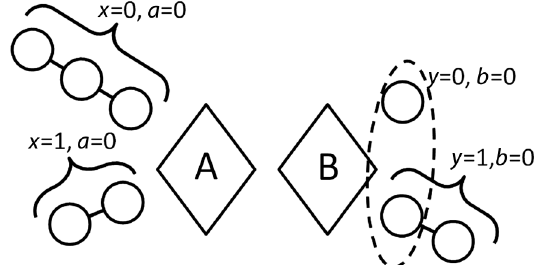
FIG. 1. Pictorial representation of the state constraints: The diamonds (heads) denote Alice ’ s and Bob ’ s state spaces; the circles represent rank-one projectors. N circles joined by a line (legs) must be understood as living in the symmetric space of N particles. In the figure, Alice ’ s projectors j u 1 ih u 1 j , j u 2 ih u 2 j are represented by legs of lengths 3, 2, respectively. Also, positivity has been imposed under the partial transpose of one of the circles of Bob ’ s first leg and Bob ’ s second